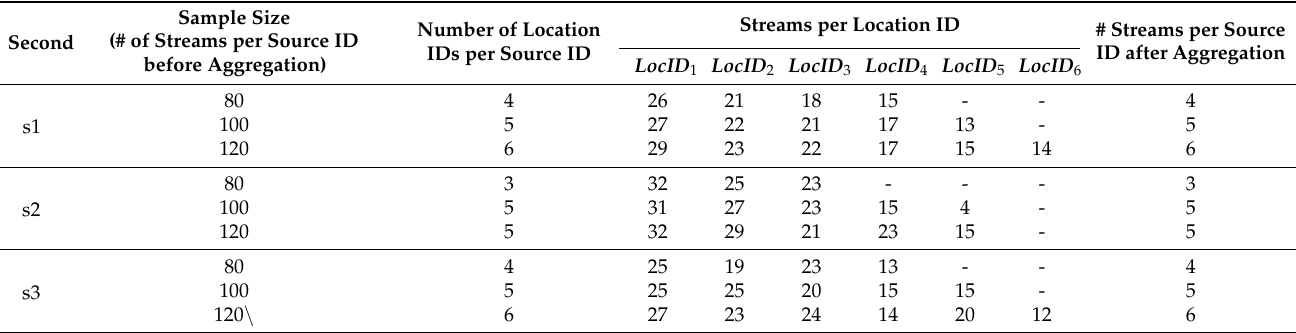
Table 6. Three seconds of service1’s simulation regarding the IoT-based Spatial Data Handler and the IoT-based Temporal Data Aggregator.